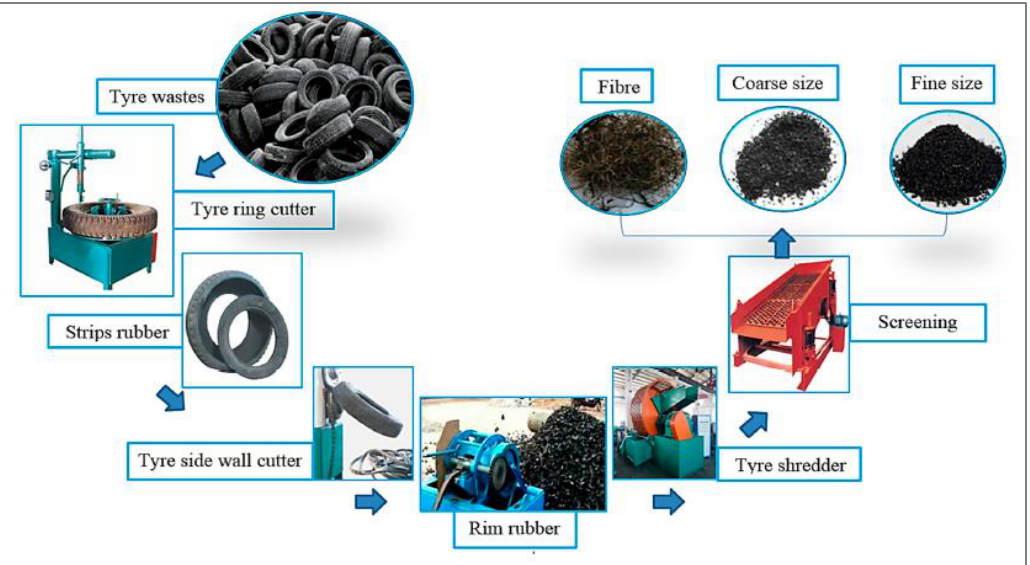
Figure 3. Flow chart of waste rubber tires from waste into concrete